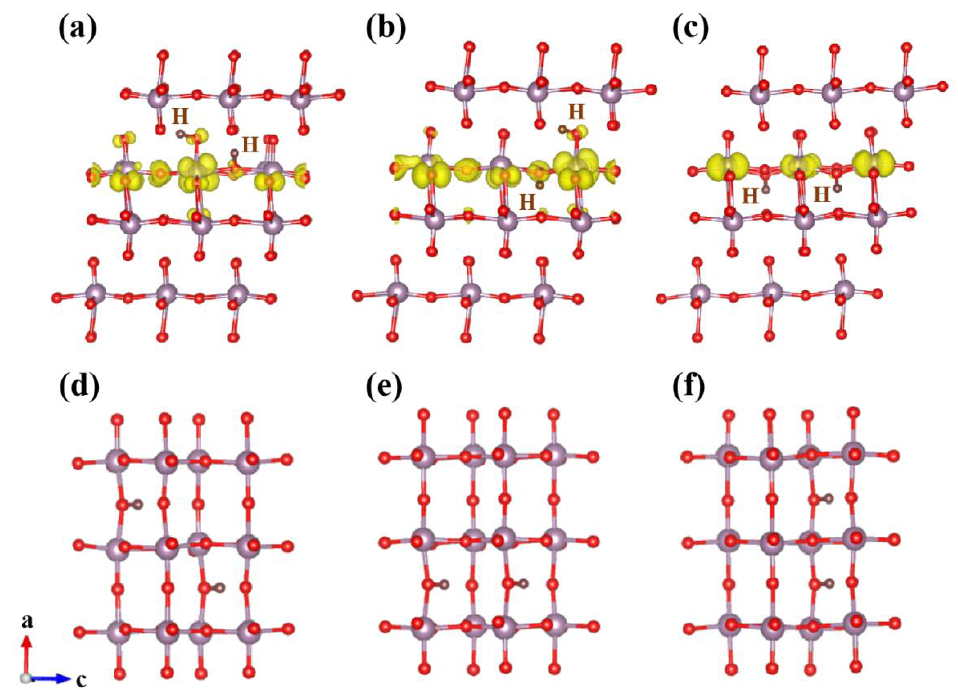
Figure 5. ( a ) Partial charge density distribution of gap state in AA site. ( b ) Partial charge density distribution of gap state in AB site. ( c ) Partial charge density distribution of gap state in BB site. ( d ) BB state [101] direction. ( e ) BB state [001] direction. ( f ) BB state [100] direction.